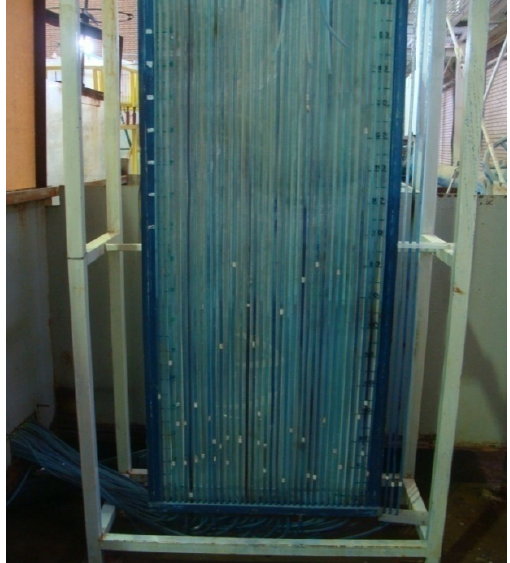
Figure 3. The 37 piezometers connected to impact plate for observation of dynamic pressure Figure3. fluctuations.